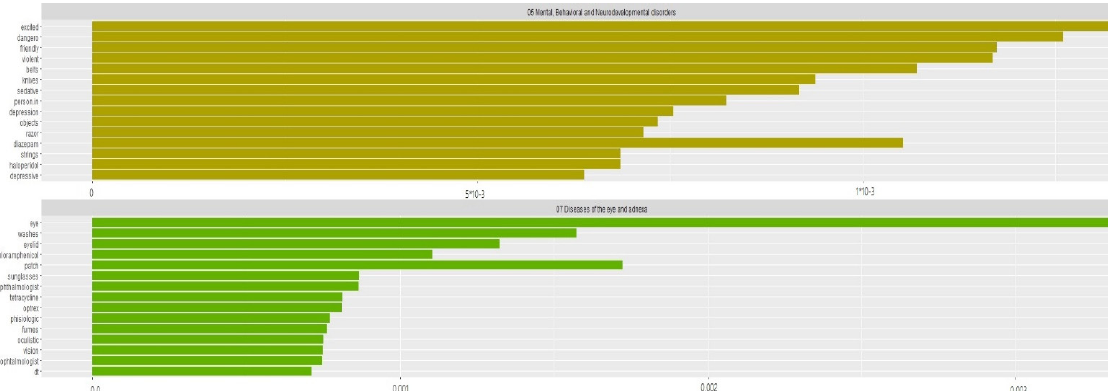
Figure 5. TF-IDF word count for mental health and eye diseases category; the highest frequency